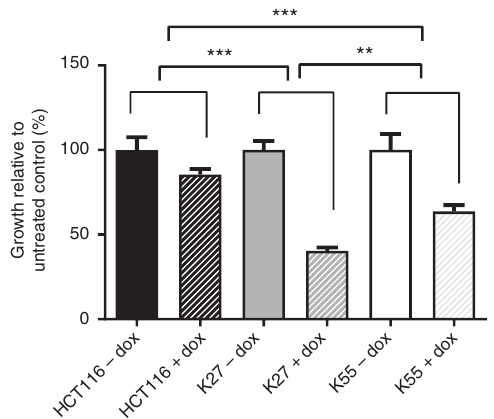
Figure 8 | Effect of intracellular expression of K27 and K55 on anchorage-independent growth. Parental HCT116 cells and lentivirally transduced inducible K27 and K55 HCT116 cells were grown in a soft agar colony formation assay in the presence and absence of 1 m gml (cid:3) 1 doxycycline for 14 days. Anchorage-independent growth was measured by alamar blue assay fluorescence and for each cell line was normalized to its respective untreated control ( n ¼ 4). The statistical significance of the difference in growth signal observed in response to the addition of doxycycline was calculated by ANOVA followed by t -test adjusted for multiple comparisons using Bonferroni correction where ** P o 0.01